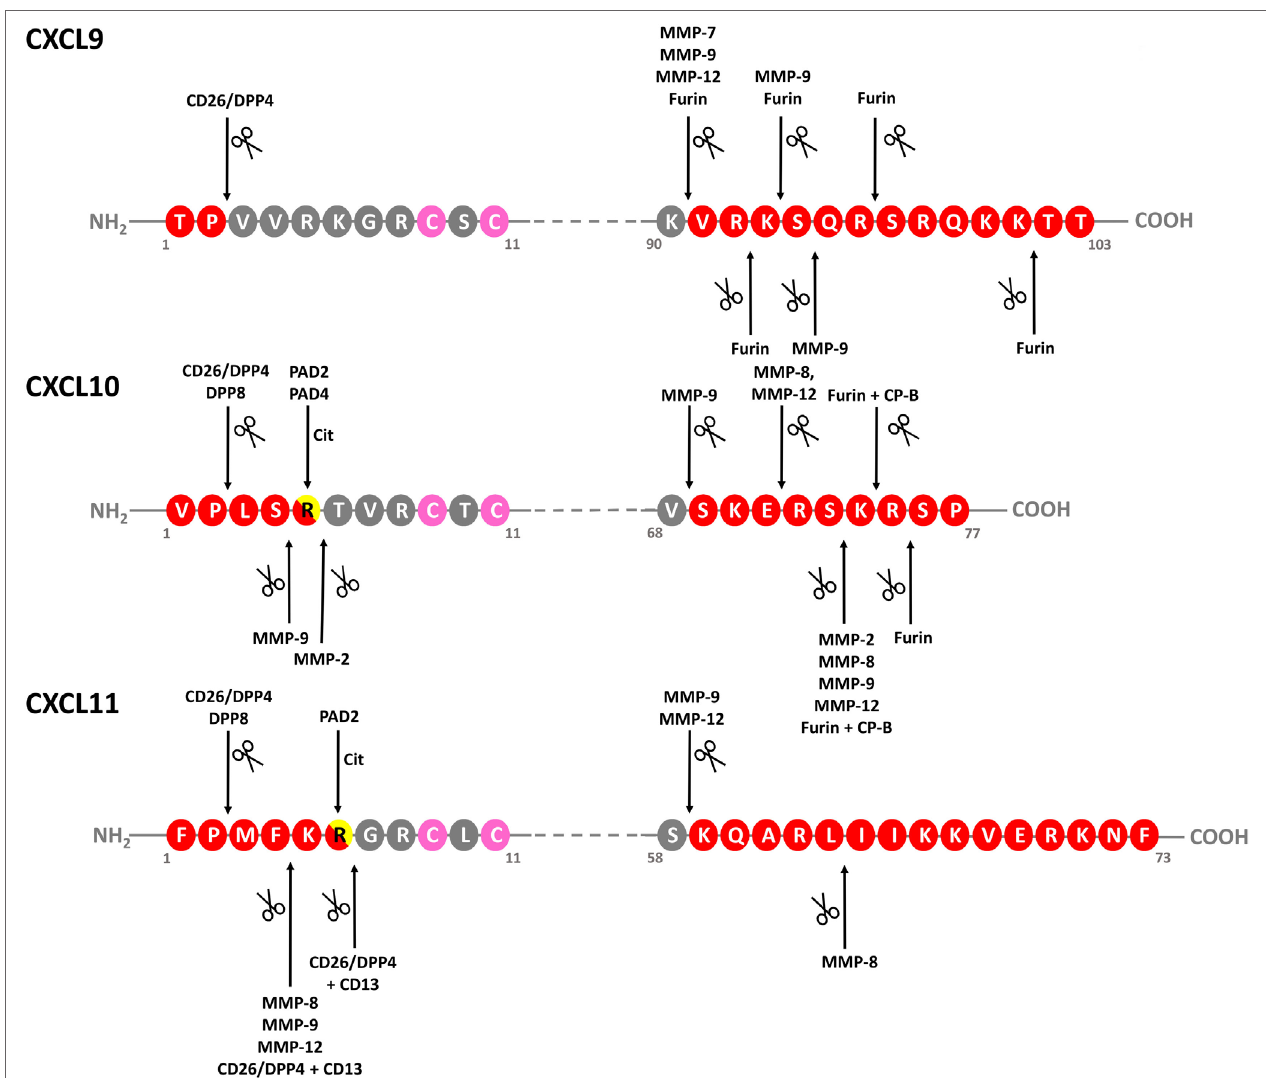
FiGuRe 4 | Identified modifications of IFN-inducible CXCR3 ligands. Schematic linear structures of CXCL9, CXCL10, and CXCL11. Enzymes responsible for chemokine modification and corresponding cleavage sites, if determined, are indicated. Conserved Cys residues are indicated in pink. CP-B, carboxypeptidase B; CXCR, CXC chemokine receptor; DPP, dipeptidyl peptidase; IFN, interferon; MMP-, matrix metalloprotease; ND, not determined; PAD, peptidylarginine